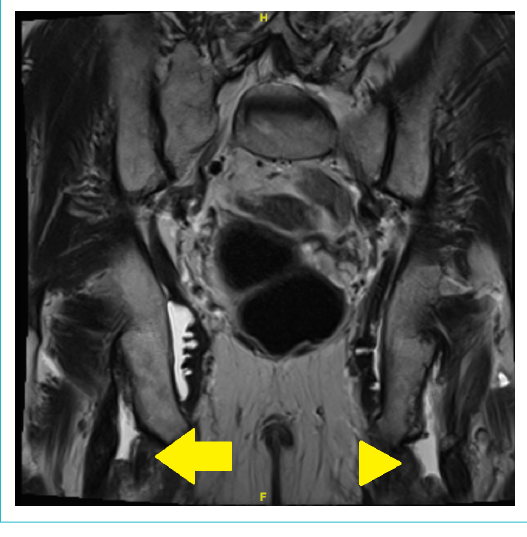
Figure 2: MRI of the pelvis with T2 turbo spin echo (TSE) weight- ed image: axial view. Arrow: partial avulsion on the right side; ar- rowhead: complete avulsion on the left side.